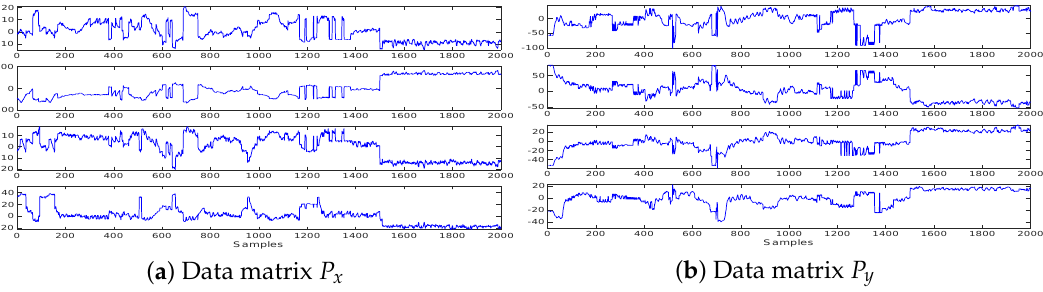
( b ) Data matrix P y